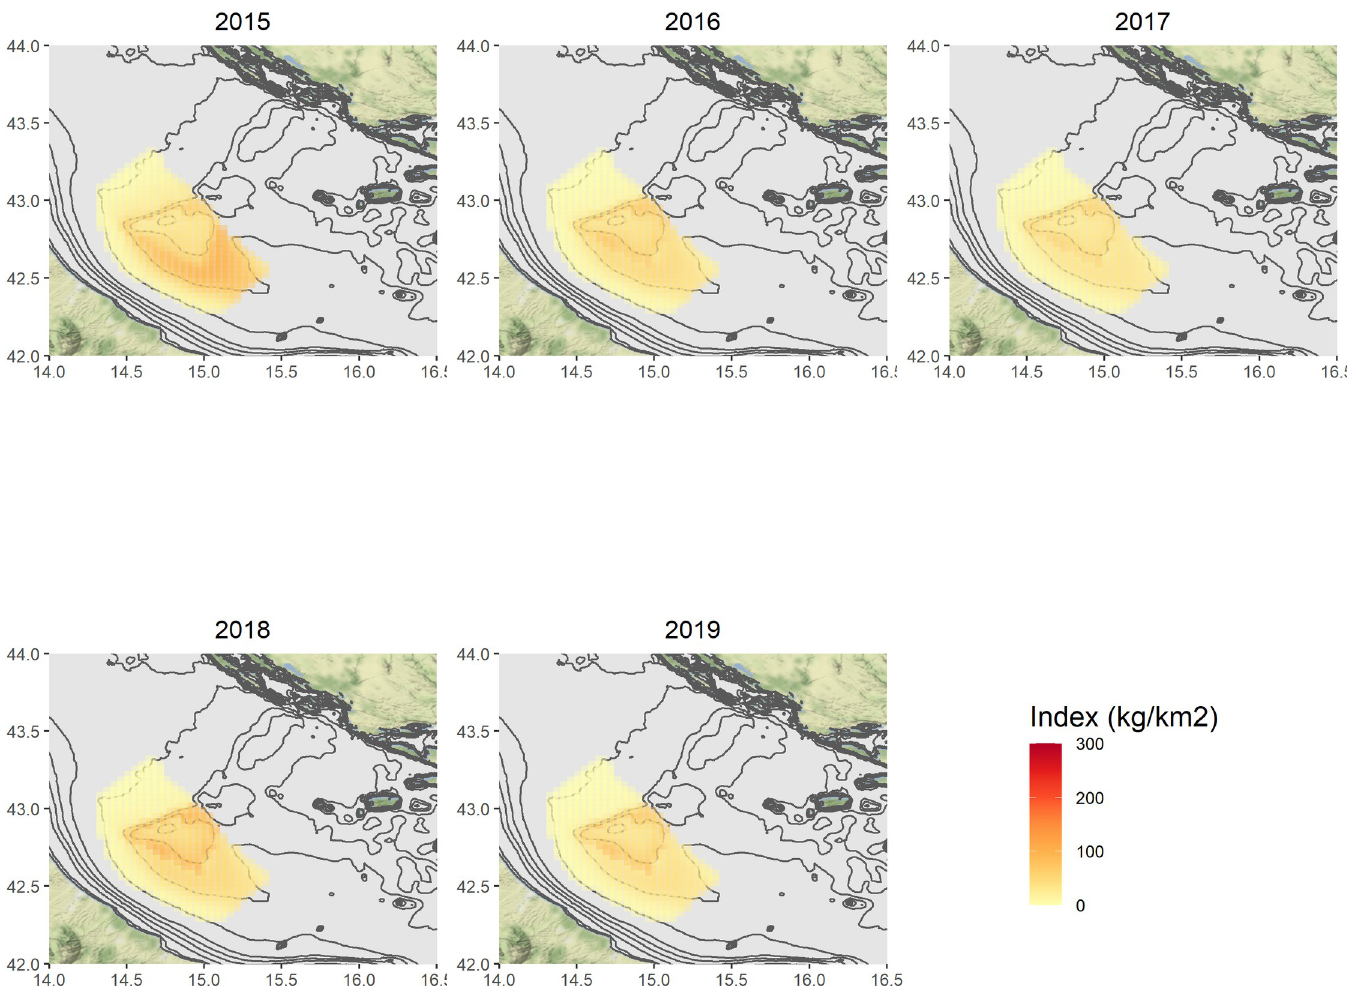
Fig 5. Predicted spatial distributions of Nephrops biomass index (kg/km 2 ) for the autumn time series. Maps were made using the ggmap package [108] for R. Bathymetry layer source: [75]. Map tiles by Stamen Design, under CC BY Data by OpenStreetMap, under ODbL.